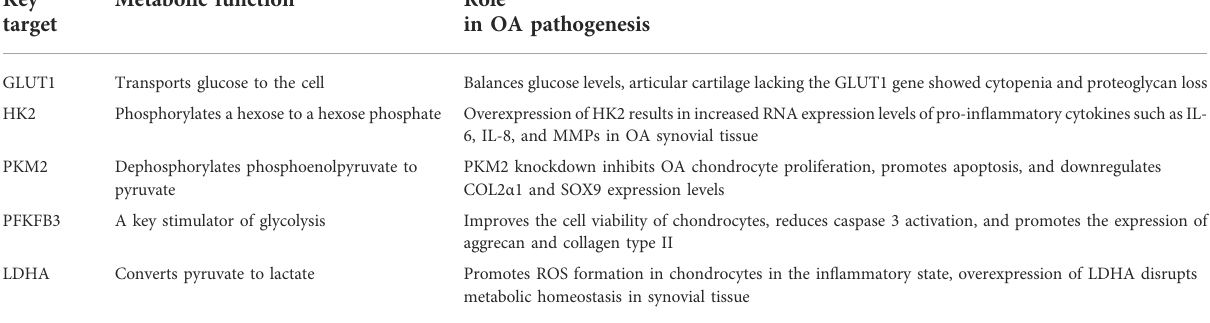
TABLE 1 The key targets in the pathogenesis of OA in